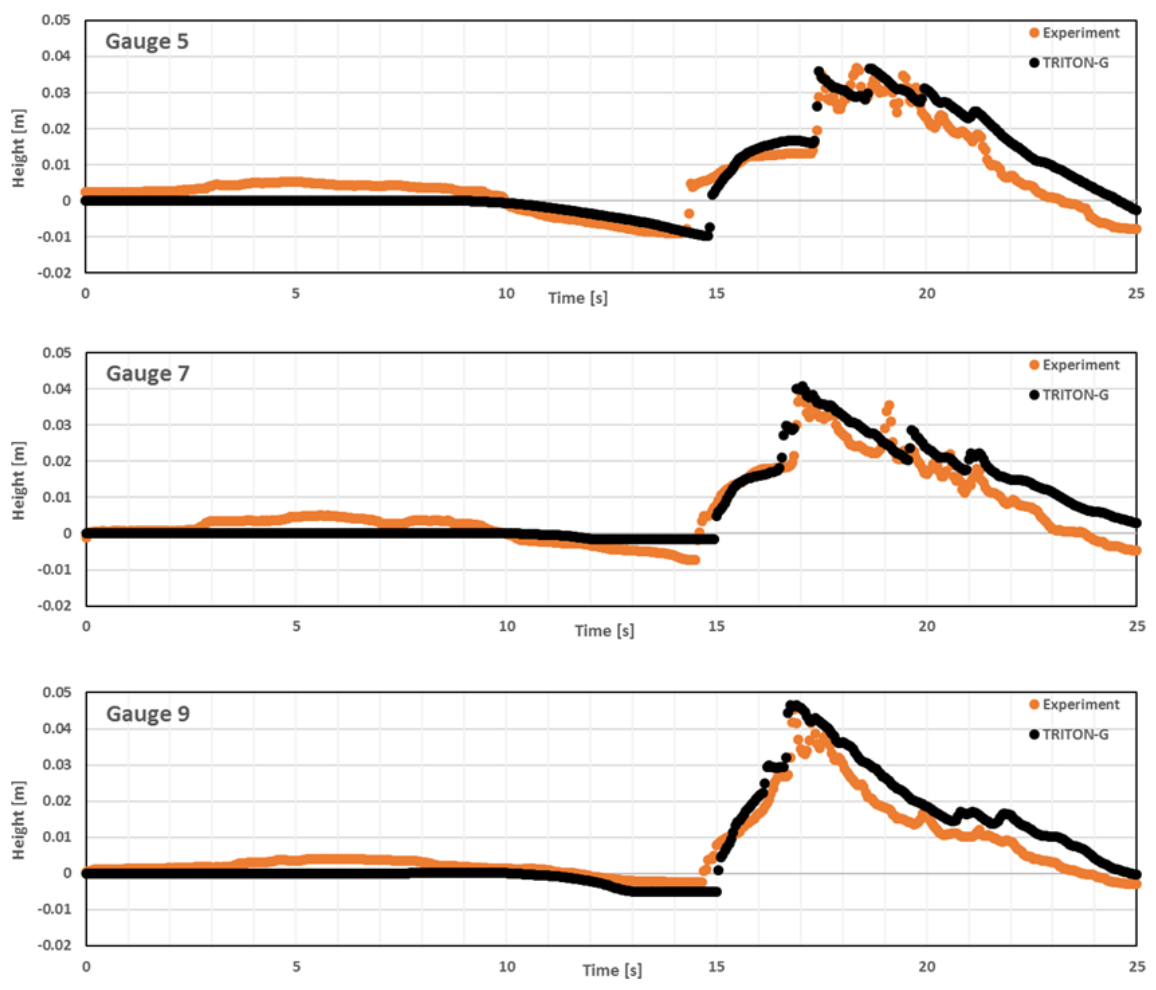
Figure A12. Water level comparison for BP7 between experiment and TRITON-G for gauges 5, 7 and